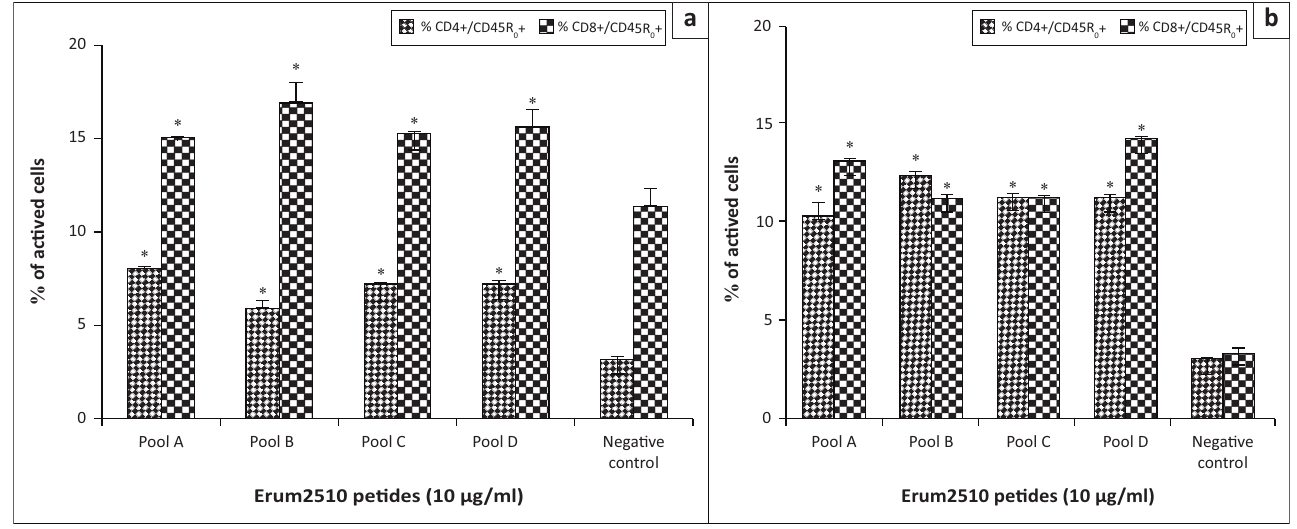
FIGURE 6-A1: Average percentage of peripheral blood mononuclear cells from s6823 (a) and sM2 (b) that stained positive for CD4 and CD45R0, and CD8 and CD45R0 expression markers after stimulation with Erum2510 peptide pools. peripheral blood mononuclear cells were stimulated with 10 µg/mL protein and incubated for 72 h after which the percentage of cells was determined by flow cytometry. Unstimulated peripheral blood mononuclear cells were included as negative